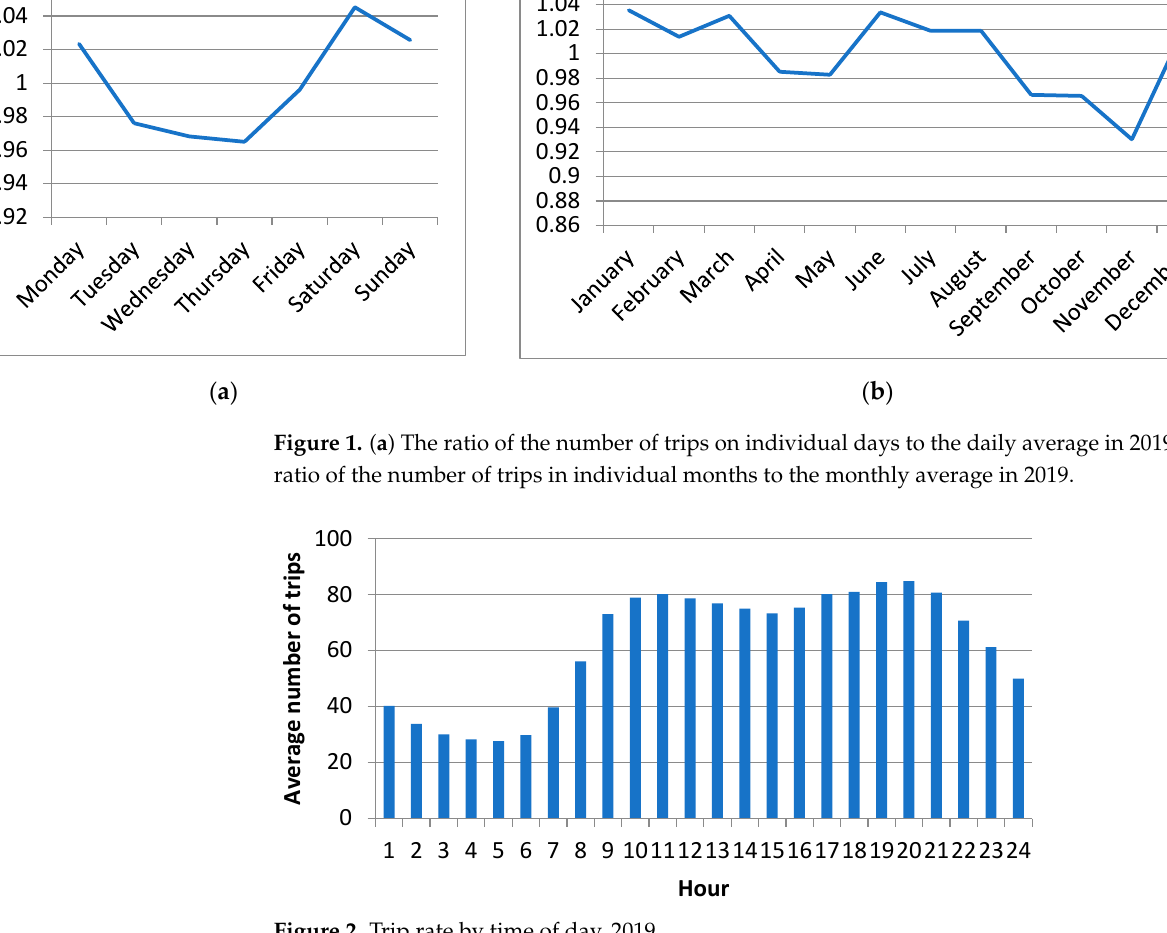
Figure 2. Trip rate by time of day, 2019.